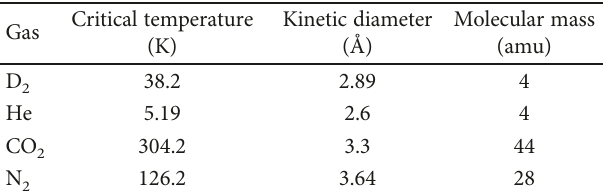
Table 1: Chemical-physical properties of the examined test gases